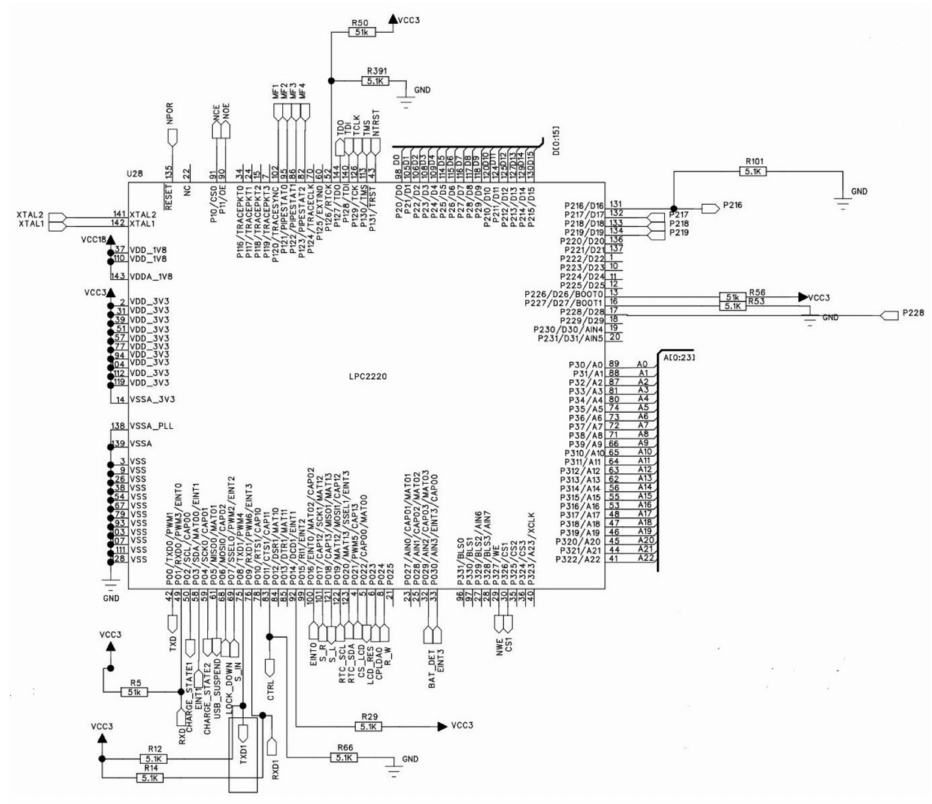
Figure 7. The logical control circuits of the RFID lock system.